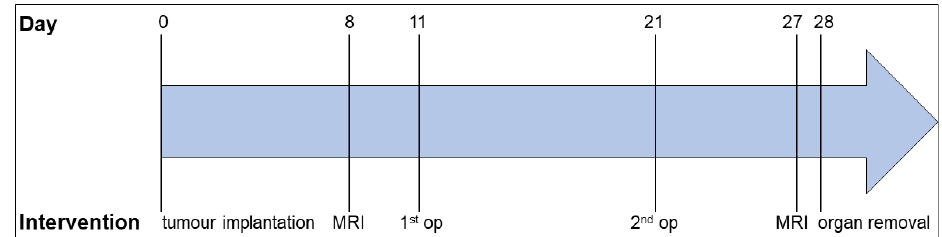
Figure 1. Experimental design. The experiment was set up for 28 days. On day 0, pancreatic tumour cells were implanted into the animal’s pancreas. On day 8, the tumour volume was determined by MRI. On days 11 and 21, SID/laparotomy/no operation was performed, followed by the second MRI scan on day 27. On day 28, the animals were euthanised, and the organs were removed for further analysis.